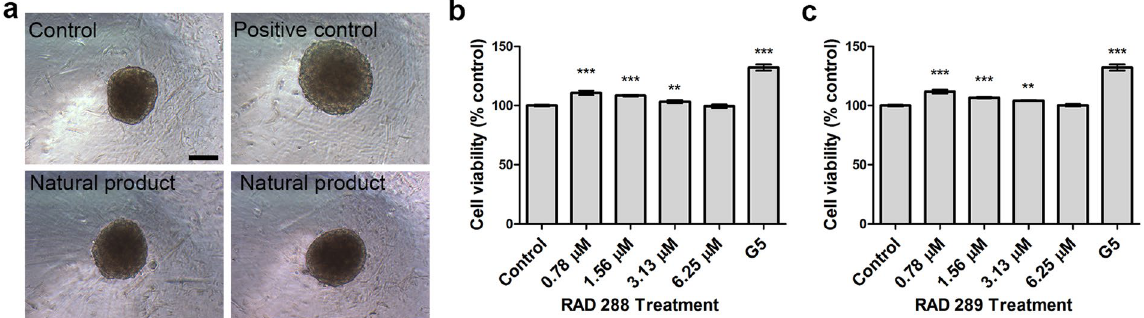
Figure 8. Effect of RAD288 and RAD289 on 3D mOECs spheroids. ( a ) Representative images of mOECs spheroids after drug exposure. Scale bar = 100 µ m. ( b ) Cell viability of mOECs spheroids exposed to 0.2% DMSO (Control), 1% G5 supplement and RAD288 (0.78–6.25 µ M) using the resazurin metabolic activity indicator. ( c ) Cell viability of mOECs spheroids exposed to 0.2% dimethyl sulfoxide (Control), 1% G5 Supplement and RAD289 (0.78–6.25 µ M) using the resazurin metabolic activity indicator. Triplicate wells were used in three separate experiments, mean ± SEM, *** p < 0.001, ** p < 0.01, Student’s